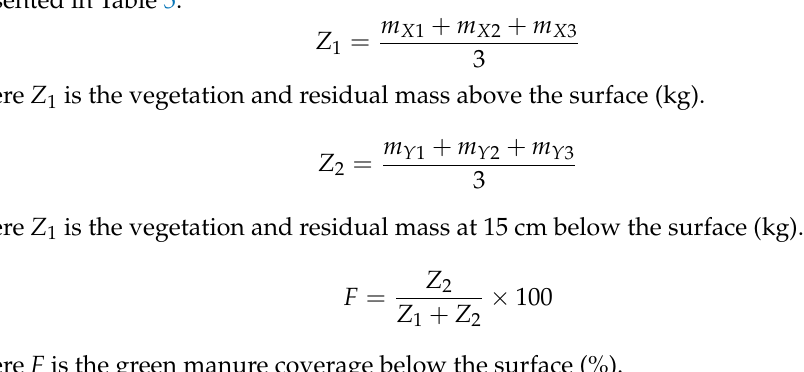
Figure 10. Field test. ( a ) Control group field trial; ( b ) “separated burying device” Group Field Test. Five test points were chosen at an equal interval in the operation region of the machine while having 1 m 2 scope of each point. Green manure above the surface and 15cm below the surface were screened by a sieve. If the coverage length of green manure crops was shorter than 2/3 of the total length, it was determined as no coverage. Samples were collected in a sealed bag, weighed and recorded. To decrease errors, samples were weighted thrice, and the mean value was considered. With reference to the Operation Quality of Furrow Plow NY/T742-2003 , the green manure coverage after operation of the machine was calculated according to Equations (5)–(7), where m X 1 , m X 2 and m X 3 were results of three measurements of green manures above the surface at each point; m Y 1 , m Y 2 and m Y 3 were results of three measurements of green manures at 15cm below the surface at each point. Test results are presented in Table 5.